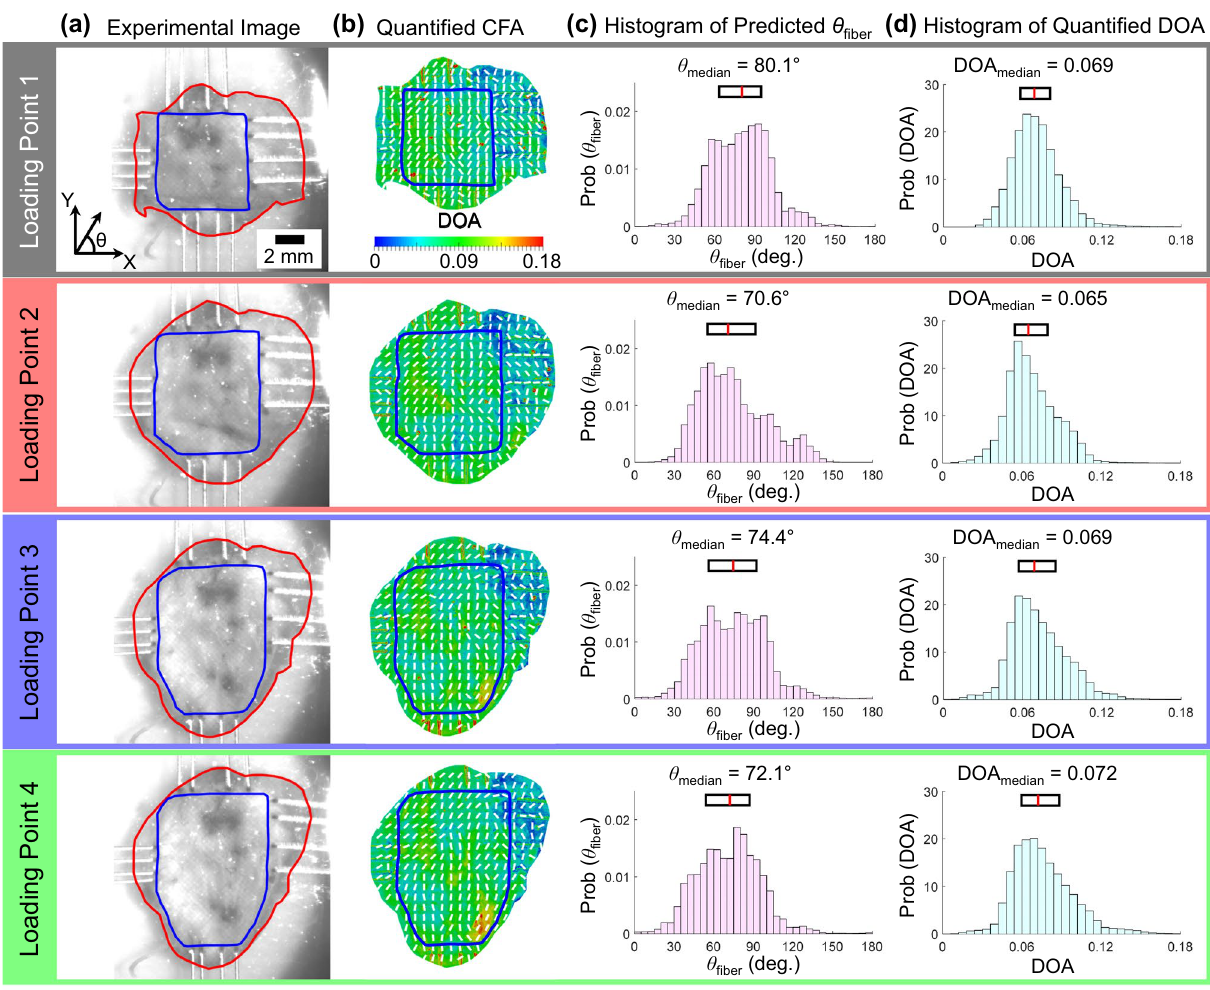
Figure 4. ( a ) Defined region of interest, ( b ) preferred collagen fiber orientation vector maps with a degree of optical anisotropy (DOA) color map, ( c ) histogram of the preferred fiber orientation, and ( d ) histogram of the DOA for the four loading points defined in the equibiaxial loading protocol (see Fig.